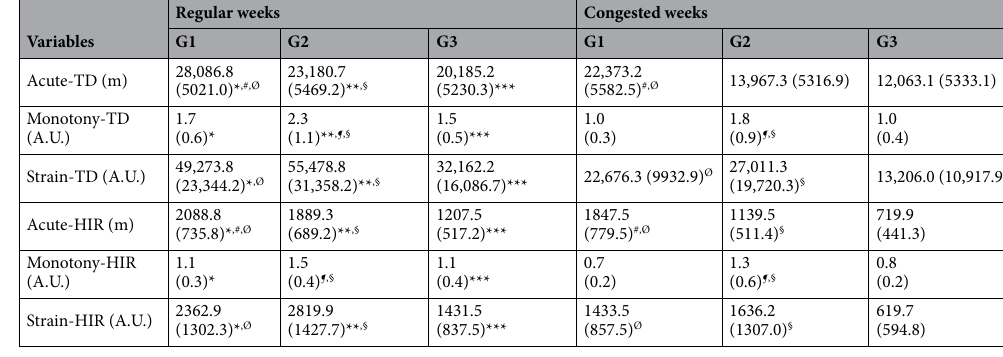
Table 2. Mean (standard deviation) of the acute, monotony, and strain indices for the total distance covered (TD) and total distance covered in high-intensity running (HSR; ≥ 18 km·h −1 ) according to congested fixture and matches’ participation. G1 = players who played ≥ 60 min; G2 = players who played < 60 min; G3 = players who did not participate of the match. * G1: Regular week > Congested week; ** G2: Regular week > Congested week; *** G3: Regular week > Congested week; # G1 > G2; Ø G1 > G3; ¶ G2 > G1; § G2 > G3.